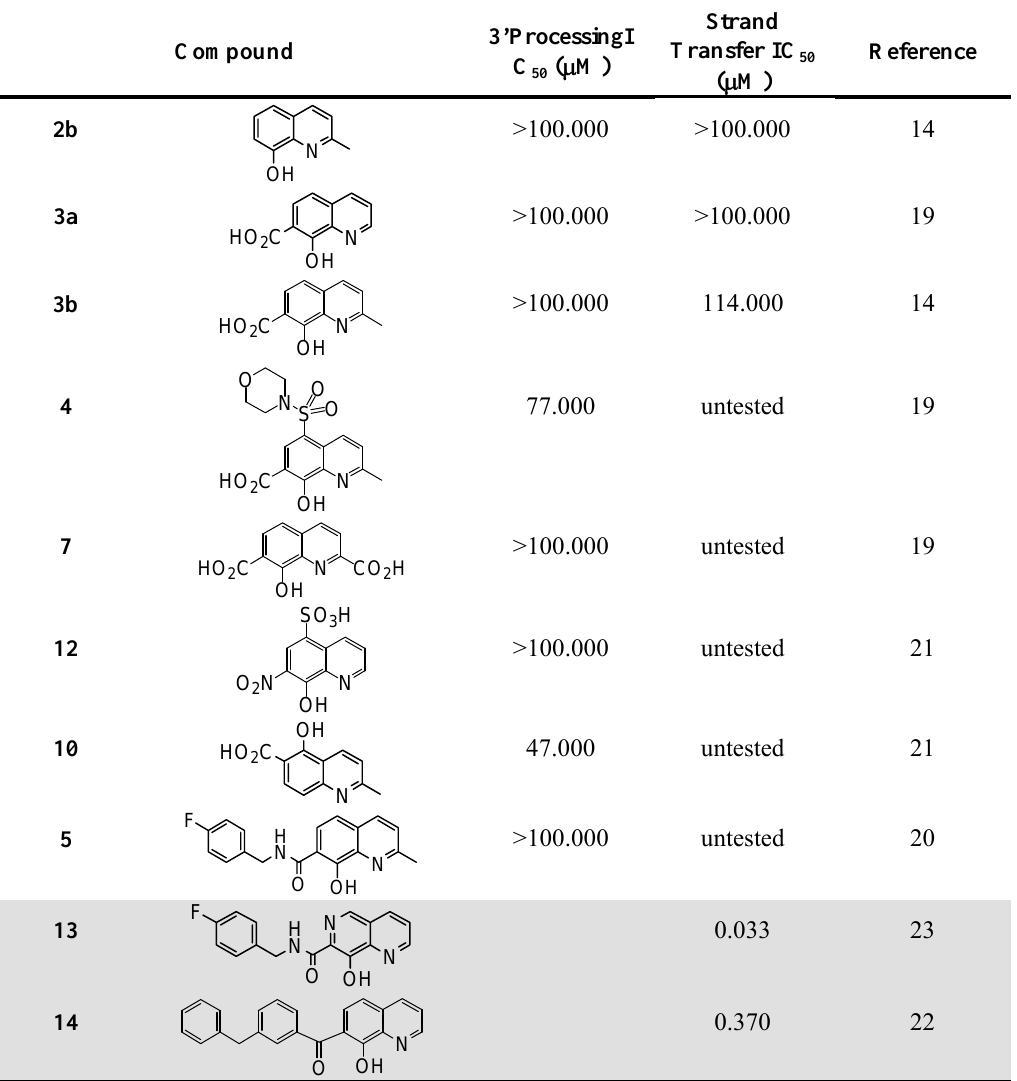
Table 1. HIV-1 IN inhibitory potency of the quinoline